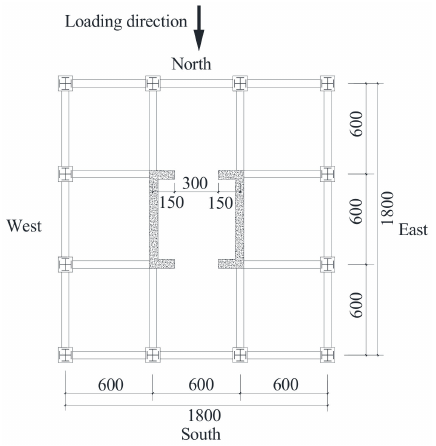
Figure 1. Plan arrangement (units: mm).